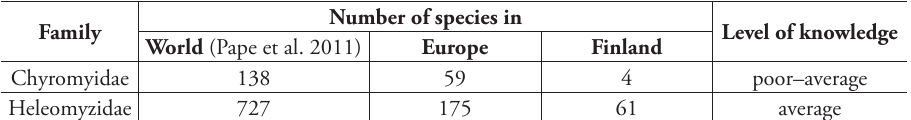
Number of species in